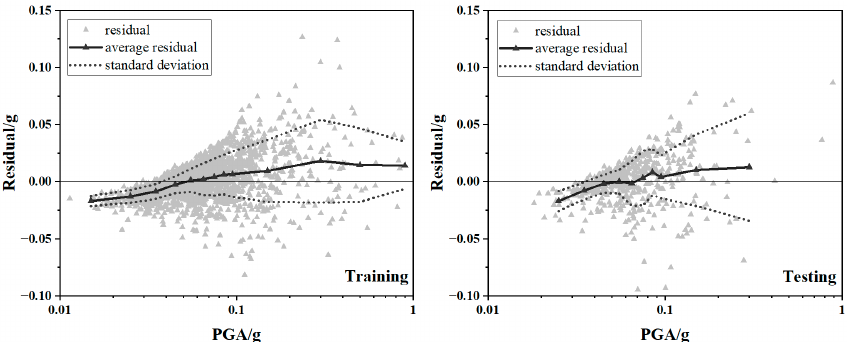
Figure 9. The prediction residuals on the training and testing dataset for XGBoost. Table 4. Defined PGA bins and associated number of seismic